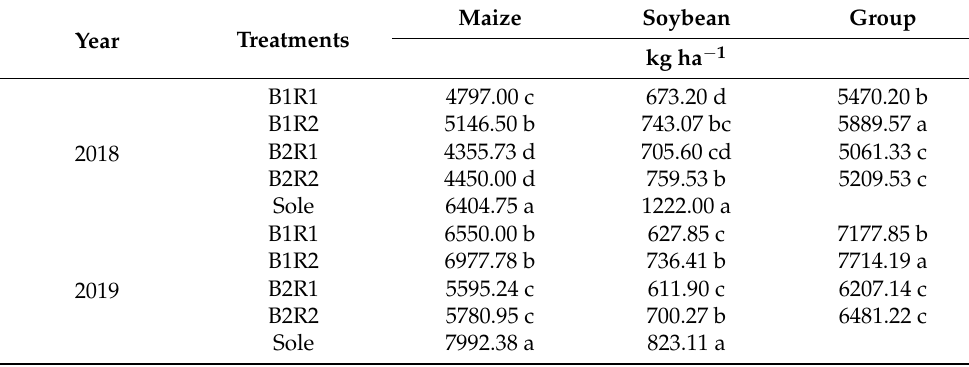
Table 3. Effect of bandwidth row ratio configuration on crop yield.